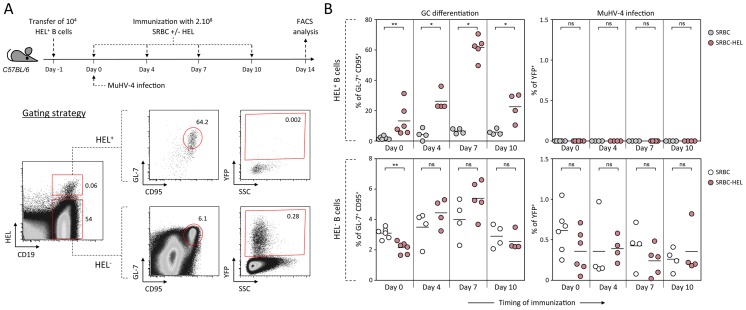
Activated HEL+ B cells remain refractory to MuHV-4 infection.(A) Experimental design: Bulk SWHEL splenocytes containing 104 HEL+ B cells were transferred in C57BL/6 mice 24 h prior YFP-MuHV-4 infection. Recipient mice were challenged intravenously by a single immunization with 2.108 SRBC or SRBC-HEL performed at 0, 4, 7 or 10 dpi. At 14 dpi, spleens were collected and analyzed by FACS. As shown in the representative FACS plots, transferred HEL+ were identified with HEL-A647 staining while transferred HEL− B cells could not be discriminated from endogenous B cells. On both HEL+ and HEL− (transferred+endogenous) B cells, GC differentiation and percentage of infection was determined using GL-7/CD95 and YFP expression respectively. (B) For each time of immunization, frequency of GC B cells and YFP+ B cells were compared between SRBC and SRBC-HEL immunized mice in both HEL+ (top panel) and HEL− B cells (bottom panel). Each dot represents an individual mouse and bars represent the average percentages. The data were obtained from 4 to 6 mice per experimental group.